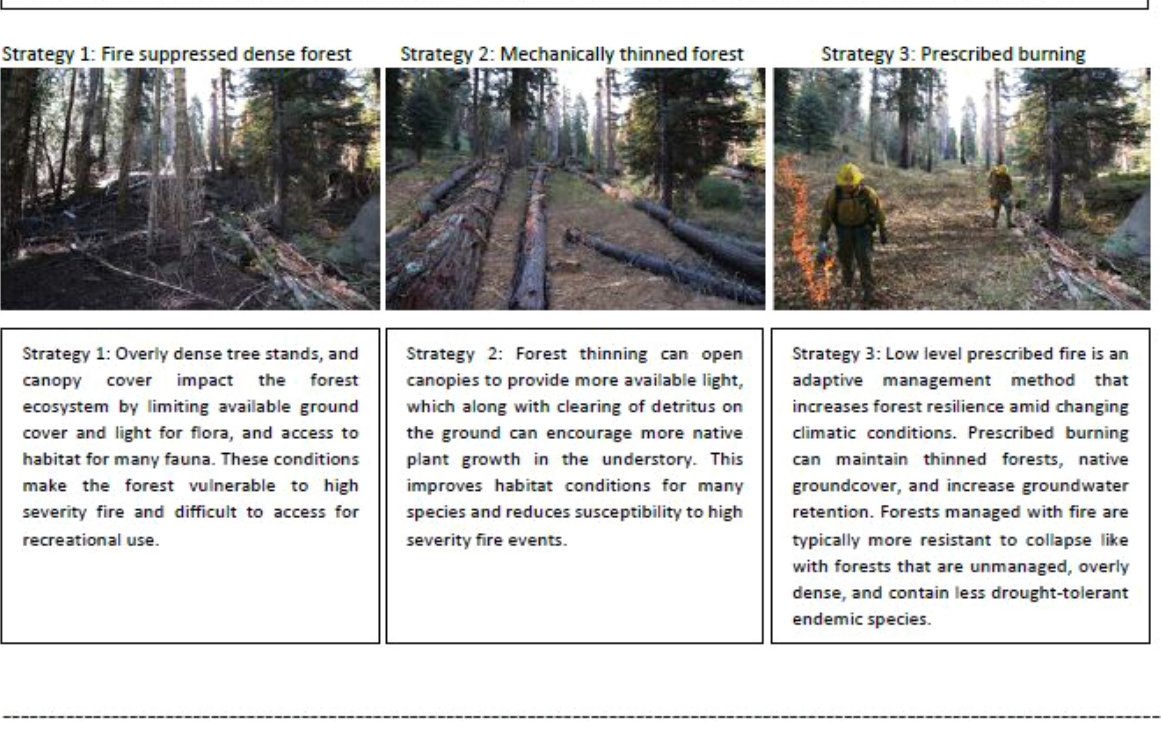
Fig. 3 . Explanatory background and strategy content differs between the text and nontext versions of the survey. Site 6 – Generals Highway Forest shown here as one scenario